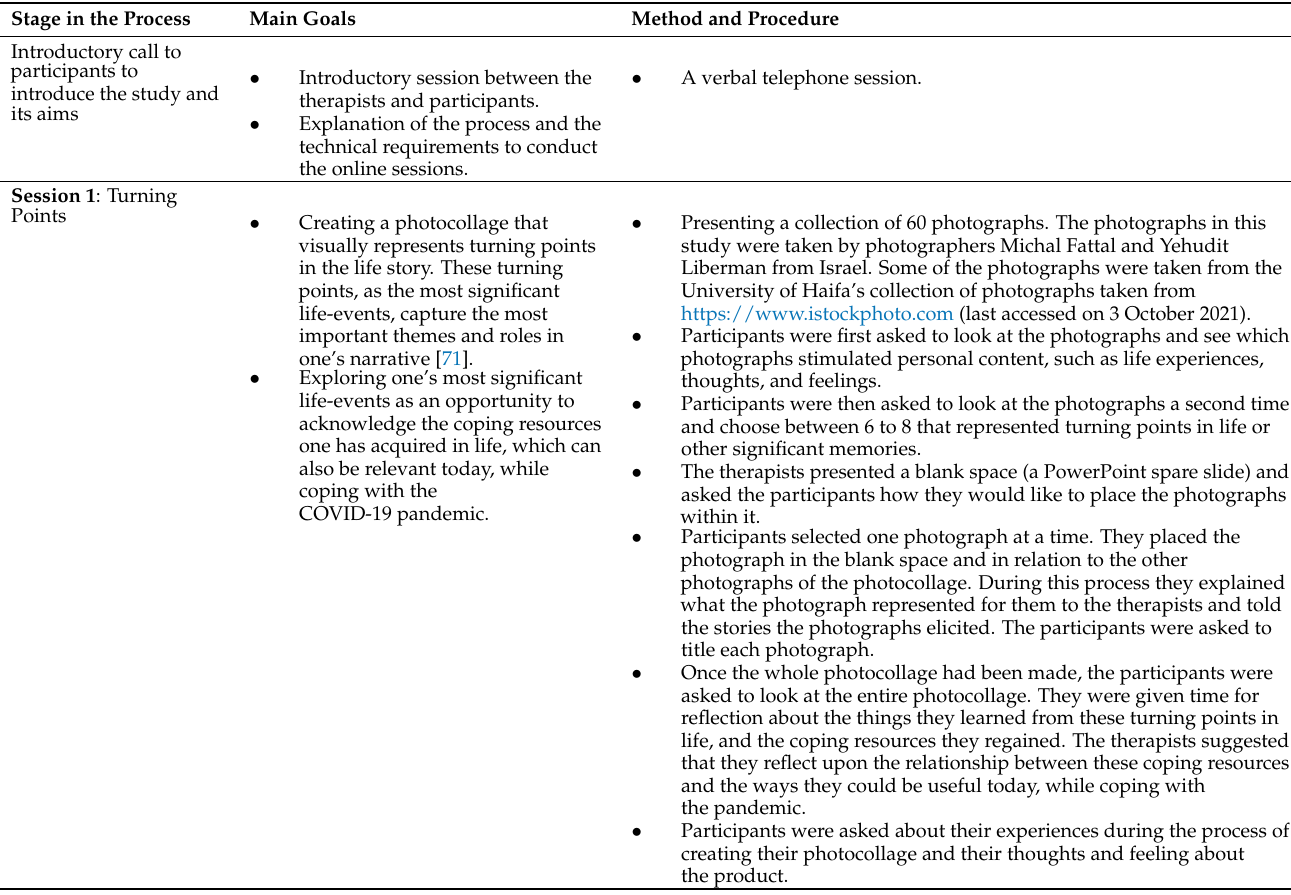
Table 2. Description of the main stages of the